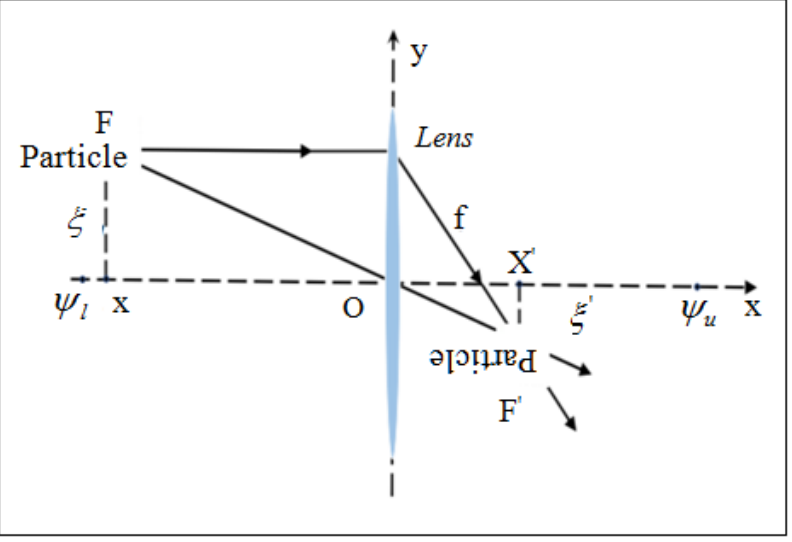
Figure 2. Dynamic lens-imaging learning strategy.